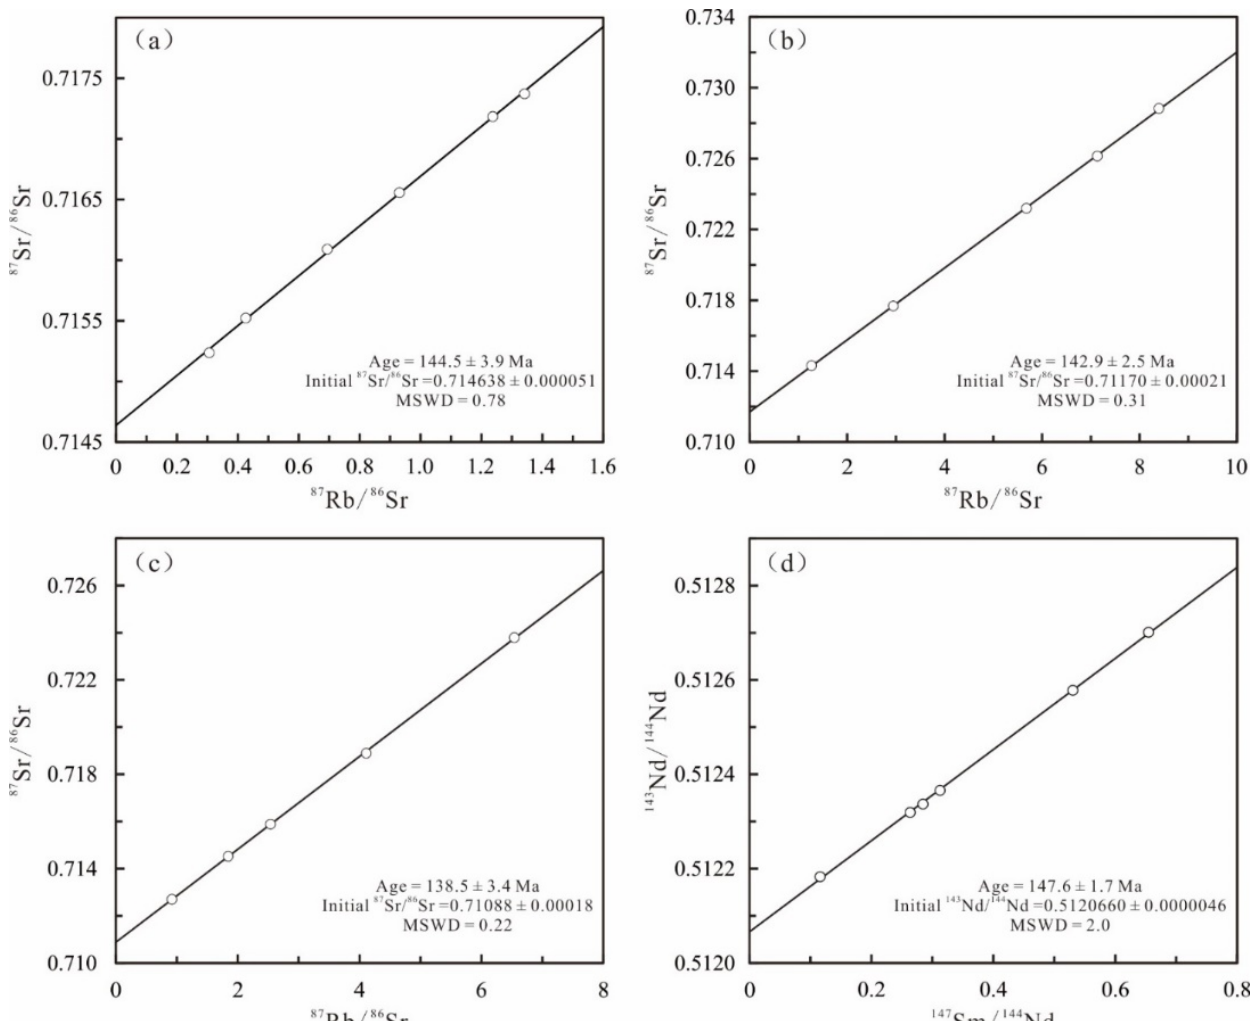
Figure 7. Rb-Sr and Sm-Nd isochron diagrams of the Laochangping and Luota Pb-Zn deposits. ( a ) Rb-Sr isochron of paragenetic sphalerites and pyrites from the Liuhuangdong orebody in the Laochangping Pb-Zn deposit; ( b ) Rb-Sr isochron of paragenetic sphalerite and pyrites from the Wanbao orebody in the Laochangping Pb-Zn deposit; ( c ) Rb-Sr isochron of sphalerites from the Laoxi orebody in the Luota Pb-Zn deposit; ( d ) Sm-Nd isochron of paragenetic fluorites and calcite from the Wujiahe orebody in the Luota Pb-Zn deposit.